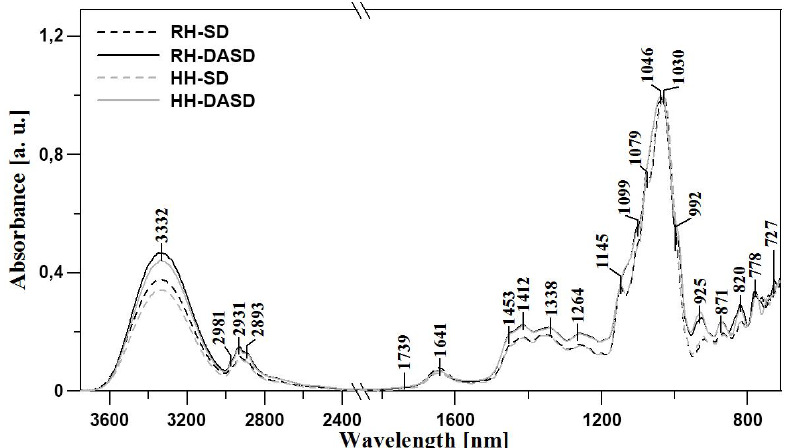
Figure 1. ATR-FTIR absorption spectra of the analyzed samples RH-SD, RH-DASD, HH-SD, HH-DASD in the spectra range 730–3750 cm −1 . 3.5. Cluster Analysis of FTIR Fingerprint of Honey Samples Figure 2A presents the classification of results for honey samples using FTIR spectroscopy done by chemometrics. The obtained results are presented in the dendrogram structure. Considering the cut-off of 0.005 dissimilarity units, two clusters could be distinguished. The first cluster (Group I) is the cluster aggregated on the far-right arm of the dendrogram. This cluster is formed by powder samples obtained by spray drying using dehumidified air (DASD powders). The second cluster (Group II) is composed of honey powders obtained after the traditional spray drying method. It could be noticed that powders after the traditional spray drying process (SD powders, Group 2) were characterized by more similar chemical properties than others. Thus, a more significant impact of the production method than the type of honey on the chemical properties of powders was found.